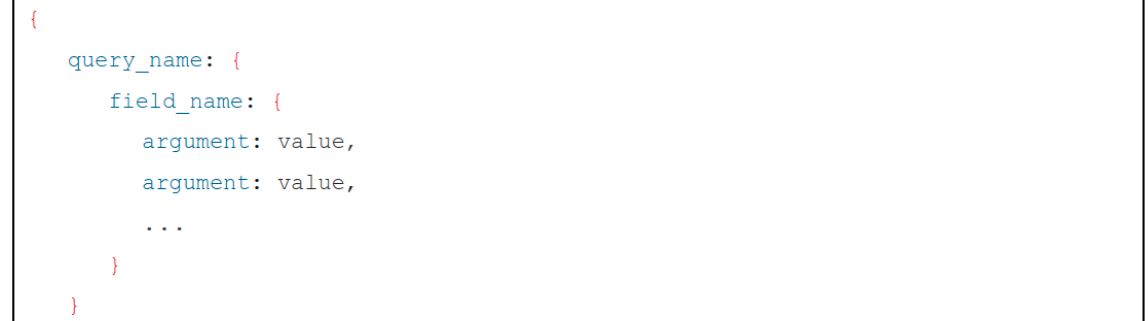
Figure 2. The structure of a query clause in Query DSL.